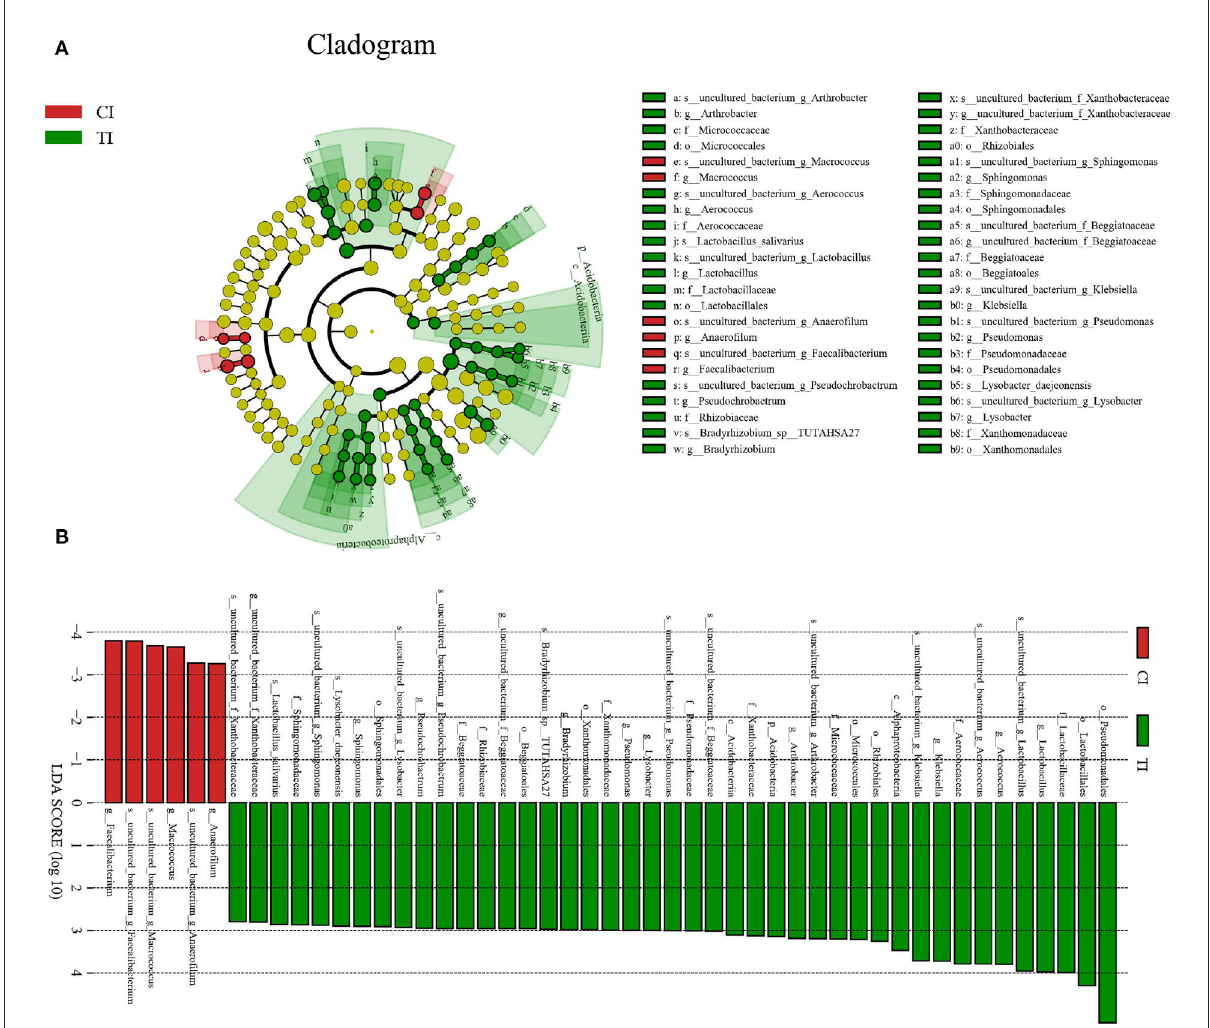
FIGURE5 Cladogram showing the phylogenetic distribution of gut microbial community related to the control and thiram-exposure groups (A) . LDA scores > 2 were considered statistically significant (B)